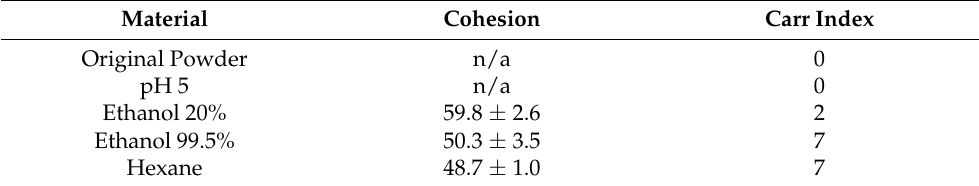
Table 3. Cohesion and Carr index of original and treated cricket powder. Material Cohesion Carr Index Original Powder n/a